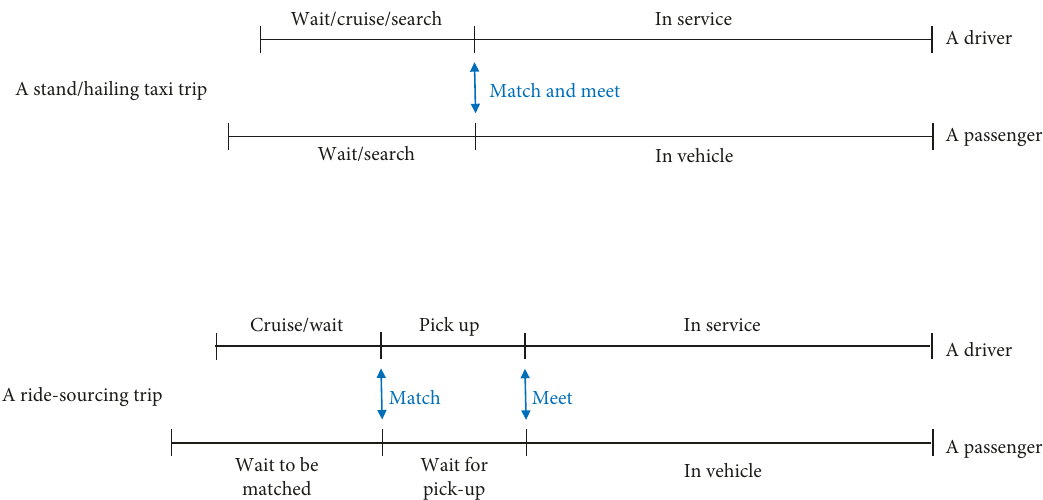
Figure 1: A comparison between stand/hailing taxi and ride-sourcing